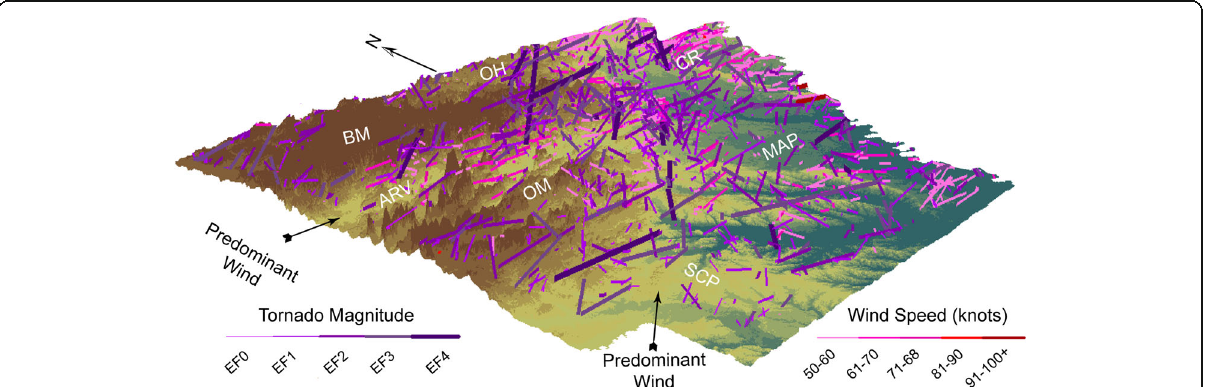
Fig. 2 Prevalent wind directions (southwesterly and westerly) and the related weather patterns (1 knot = 1.852 km/h or 1 nautical mile/h). Arkansas Physiographic provinces are indicated as: Ozark Highlands (OH), Ouachita Mountains (OM), Boston Mountains (BM), Arkansas River Valley (ARV), Crowley ’ s Ridge (CR), Mississippi Alluvial Plain (MAP), and South Central Plain